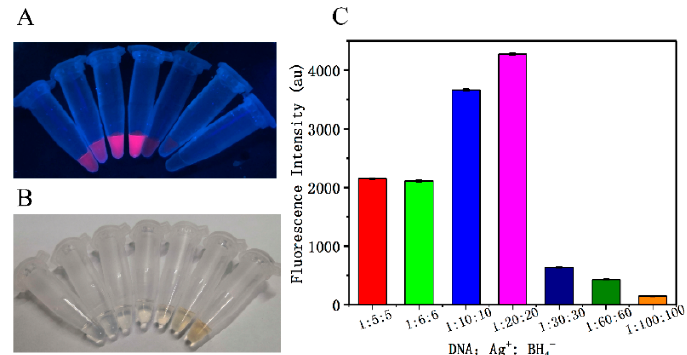
Figure 2. The images of a C6G5C6-apt-AgNC solution acquired under ultraviolet (UV) light ( A ) and under daylight ( B ). ( C ) Effect of the ratio of oligonucleotide (Table S1, Supplementary Materials) to Ag + on the fluorescence spectra of C6G5C6-apt-AgNCs.